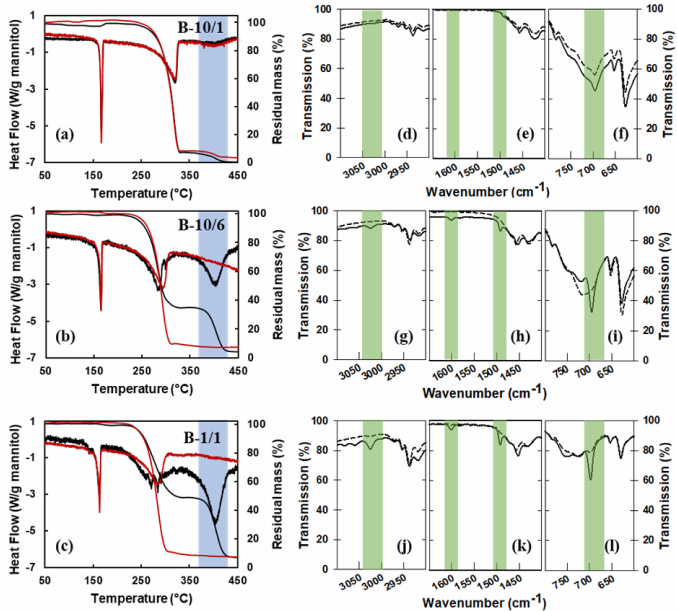
Figure 3. Influence of the M/PS mass ratio on the etching efficiency: ( a – c ) TG–DSC curves (5 K/min in helium) of the spray dried granules before etching (black curves) and after etching (red curves); ( d – l ) zooms in three regions of the IR spectra of the spray‑dried granules before etching (plain curves) and after etching (dashed curves), with the green‑shaded areas highlighting characteristic PS vibrations: − 1 − 1 − 1 aromatic C–H stretching at 3025 cm , aromatic C=C stretching at 1500 cm and 1600 cm and − 1 aromatic C–H bending at 700 cm [49]. The spray‑dried samples in this figure were obtained with the lab‑scale Büchi spray